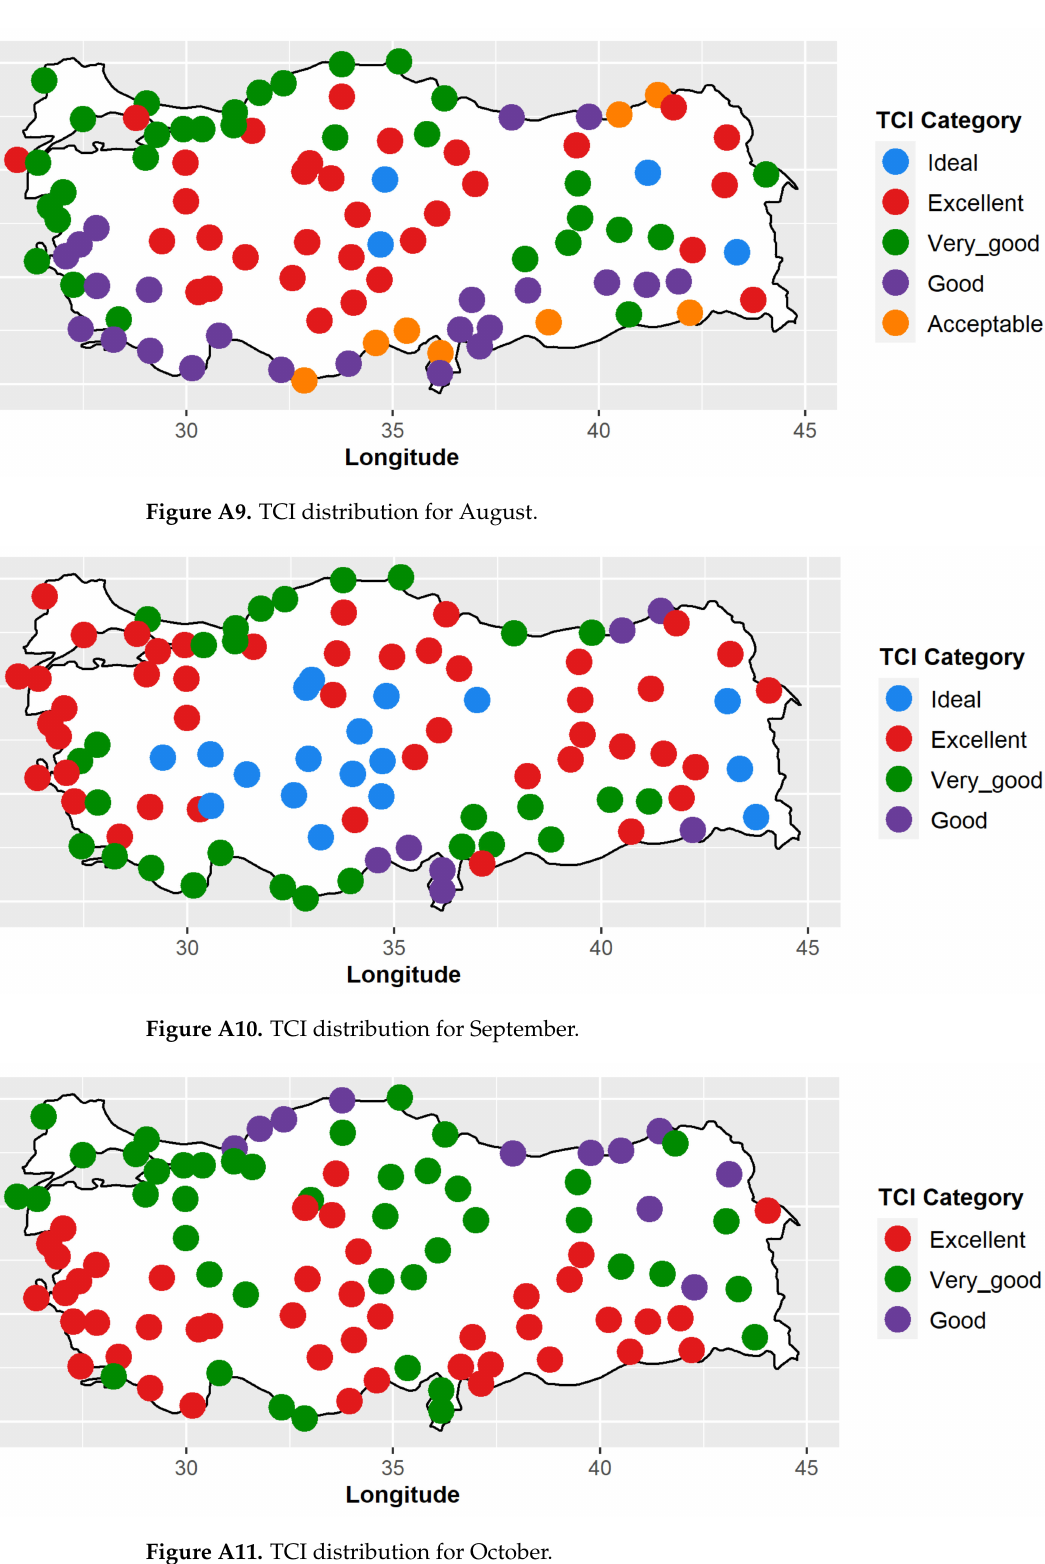
Figure A11. TCI distribution for